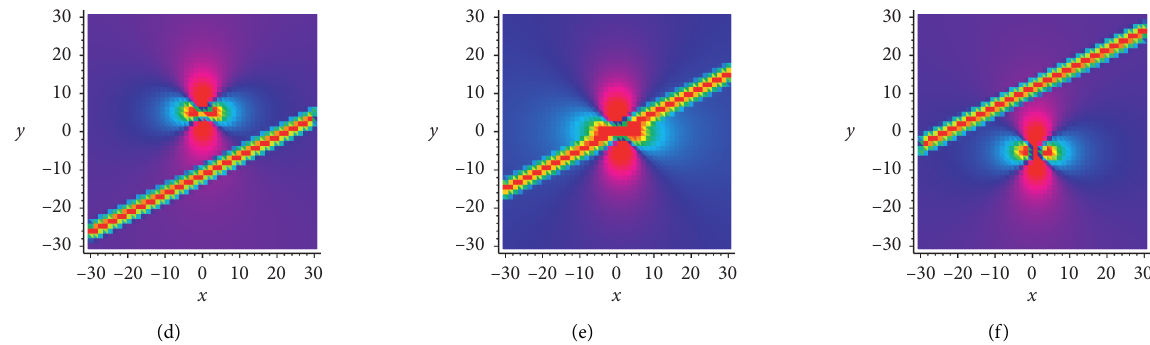
Figure 7: Evolution graphs of third-order lump solution given: (a), (b), and (c) three-dimensional plots at t � − 5, t � 0, and t � 5 and (d), (e), and (f) density plots at t � − 5, t � 0, and t � 5.